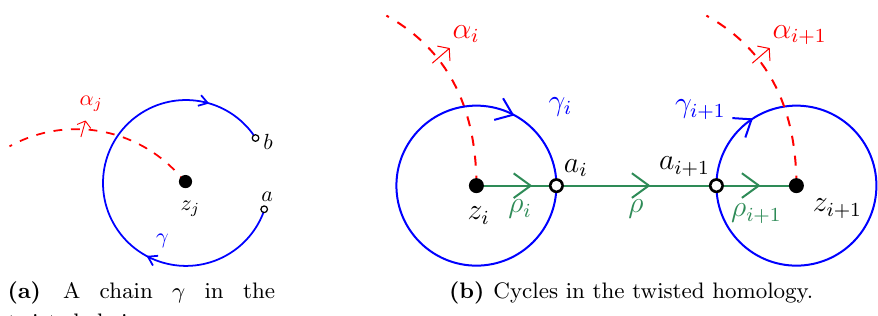
Figure 4. Examples of twisted chains and